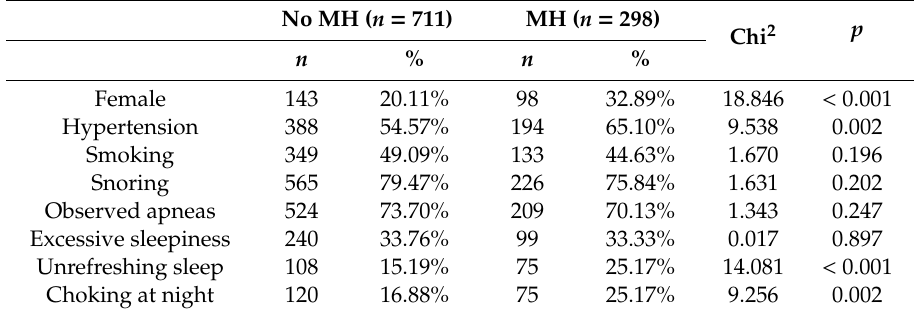
Table 2. Prevalence of women, smoking, hypertension, and chosen clinical symptoms related to sleep-disordered breathing in the studied sample.